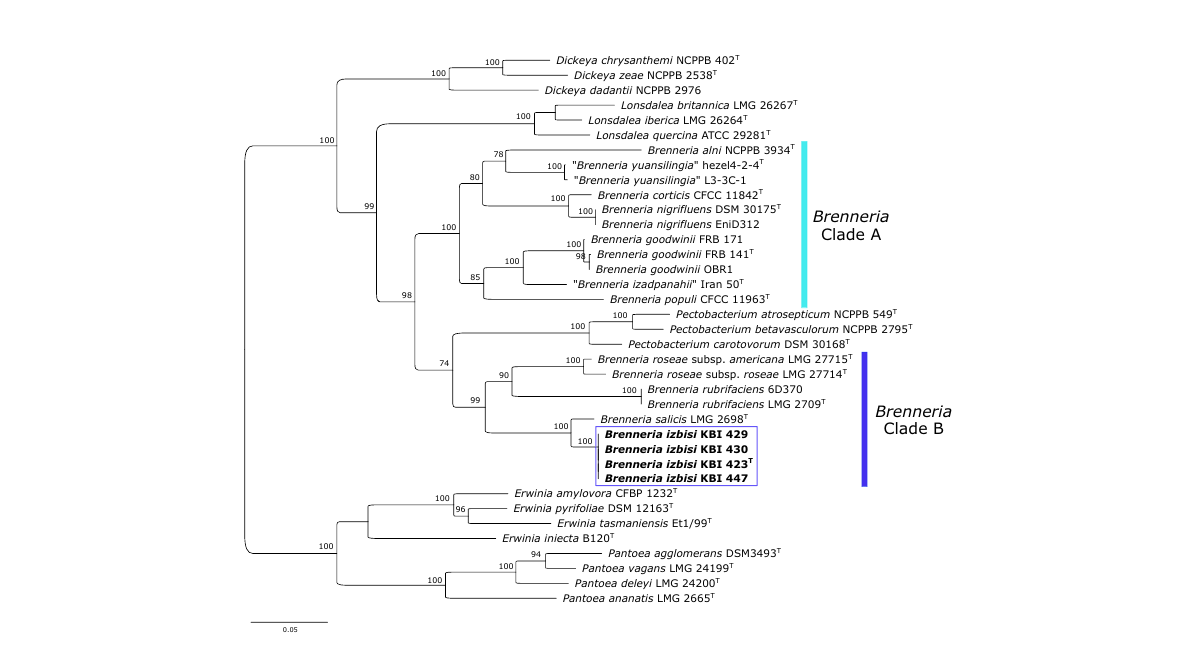
FIGURE 4 Maximum likelihood phylogenetic tree based on concatenated housekeeping genes atpD, gyrB , infB and rpoB, ( 2480 bp) sequences. The tree indicates the phylogenetic position of 4 representative B. izbisi strains (marked in bold and boxed). The best fi tting model TIM2+F+I+G4 was applied for tree construction. Ultrafast bootstrap support values (>70) are indicated at the nodes. Reference Erwinia spp. and Pantoea spp. were used as an outgroup to root the